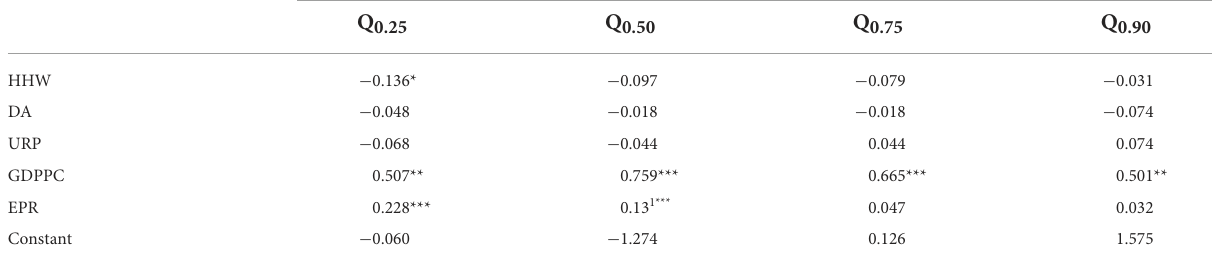
TABLE 9 Robustness test—quantile regression –